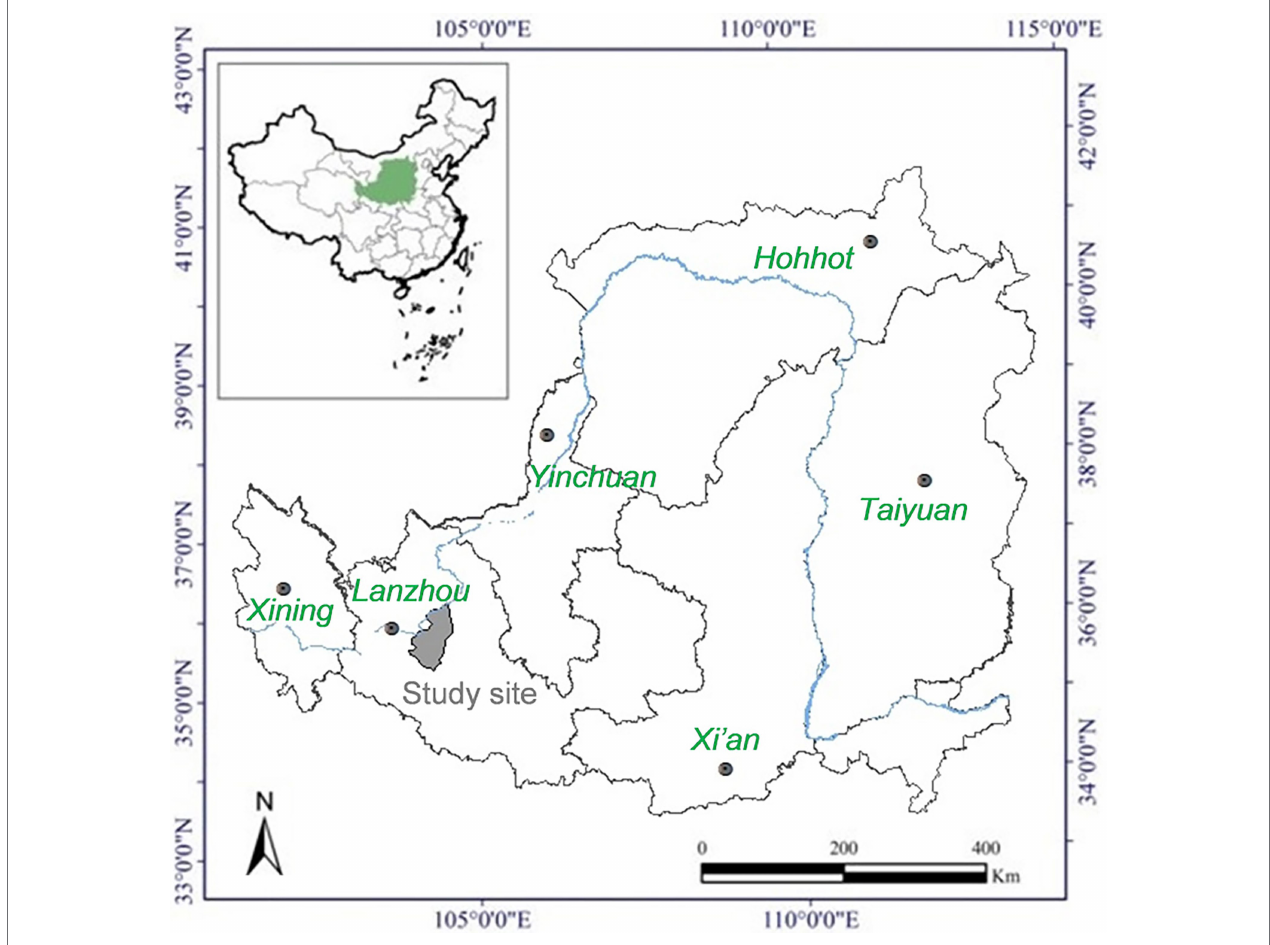
FIGURE 1 | Location of study site on the Loess